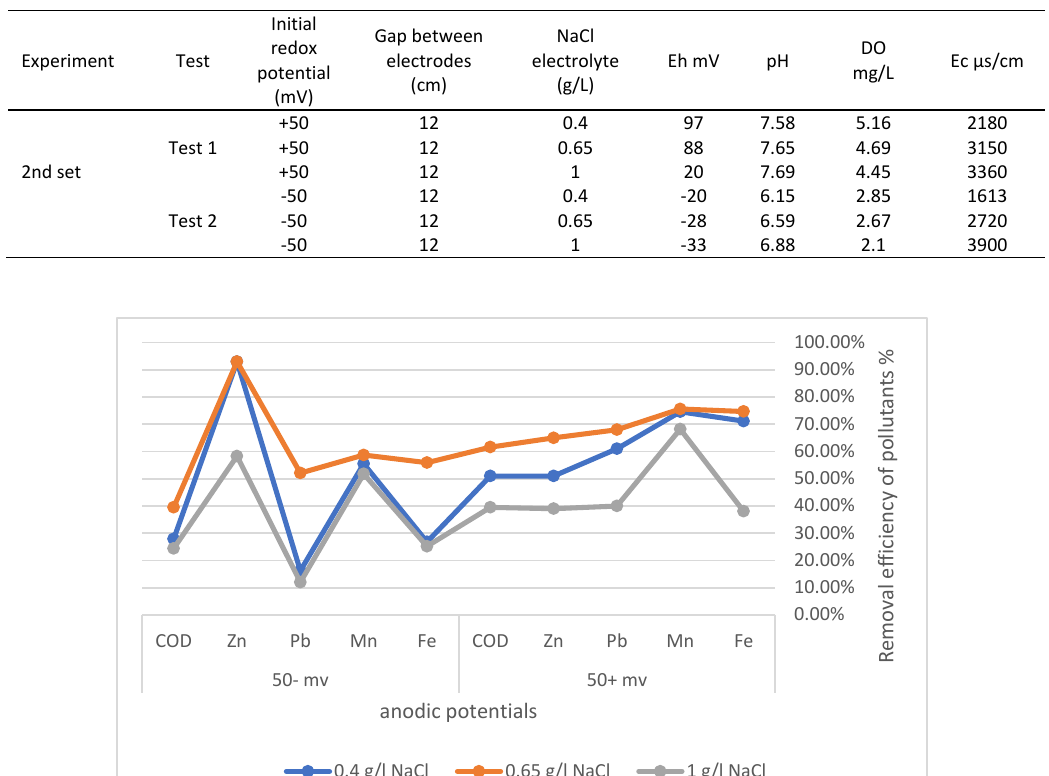
Table 2: The summary of the experimental conditions and development of several quality parameters of rainwater (after PEC) with the initial anodic potential (2.5V); gap (12 cm); pH (7.3); electrode material: Ti/TiO 2 - Gr